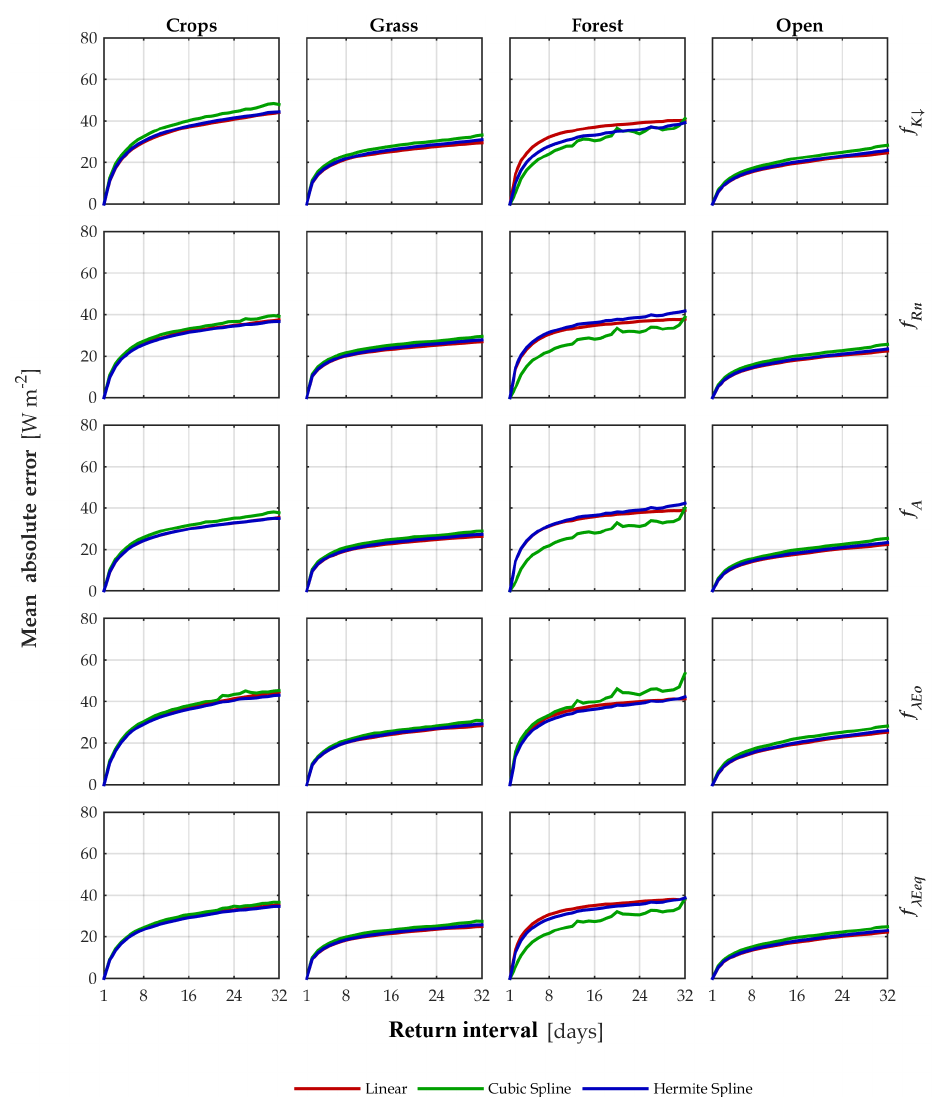
Figure 8. The mean absolute error (MAE) of the latent heat flux derived from each of the scaled quantities is shown for each land cover type and interpolation